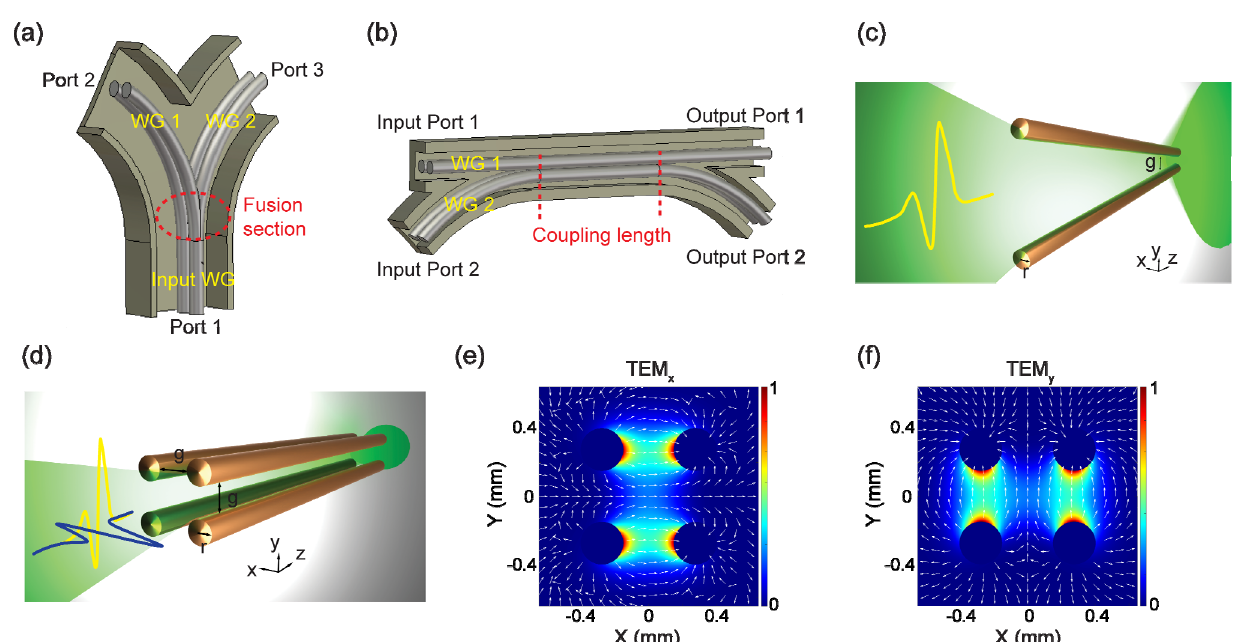
Figure 3. THz metal − wire signal processors realized by varying the geometries or topologies of the wires. ( a ) Schematic of a THz Y-shaped splitter that uses two fused TWWGs redirected into different paths, adapted from [37]. ( b ) Schematic of a THz directional coupler achieved by attaching two TWWGs, adapted from [39]. ( c ) Schematic of a THz time-domain integrator based on a tapered TWWG, adapted from [40]. The waveguide has an input gap of 1100 µm with a tapering angle of 0.36 ◦ and a total length of 85 mm. ( d ) Schematic of a THz polarization-division multiplexer based on a four-wire waveguide (FWWG), adapted from [41]. The FWWG is composed of four identical copper wires (r = 127 µm) placed in a square geometry, separated by an equal air gap (g = 300 µm). ( e , f ) Simulated electric field distributions of the fundamental TEM modes evaluated at 0.5 THz, TEM x and TEM y , which can be efficiently excited by x-polarized and y-polarized THz beams, respectively. The arrows in the 2D distributions indicate the local electric field polarization directions.